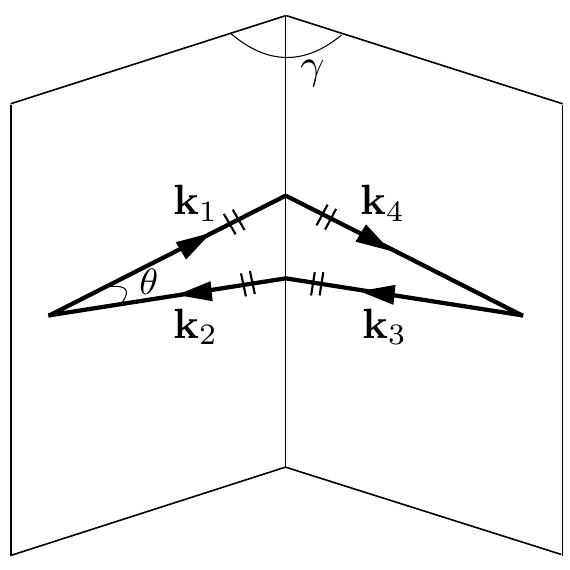
Figure 3 . Equilateral con(cid:12)gurations of four